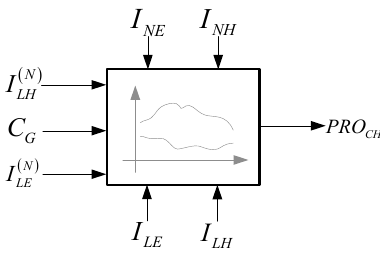
Figure 3. Equivalent profit model of CHP.